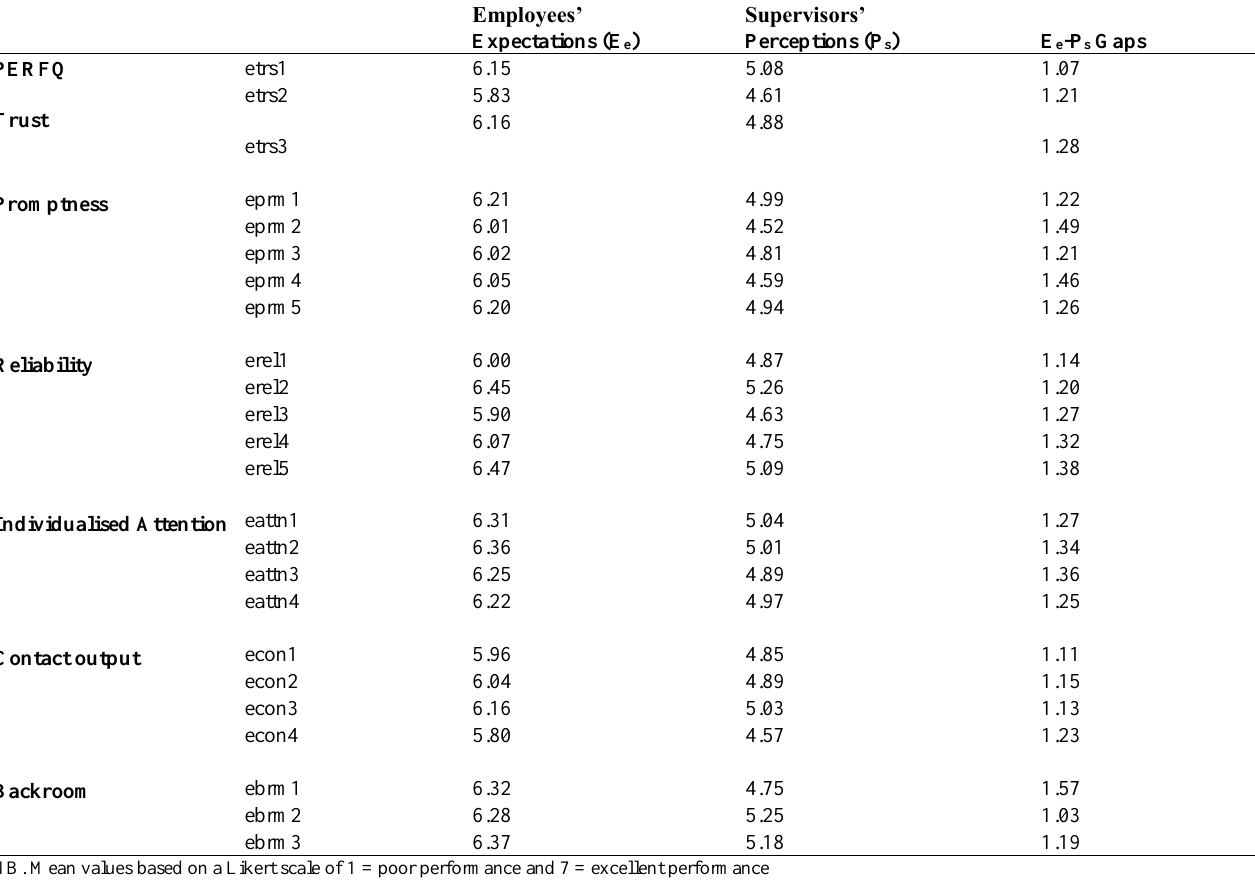
Table 2: Mean values of employees' self-reported expectations and supervisors’ perceptions of employees’ performance quality and productivity